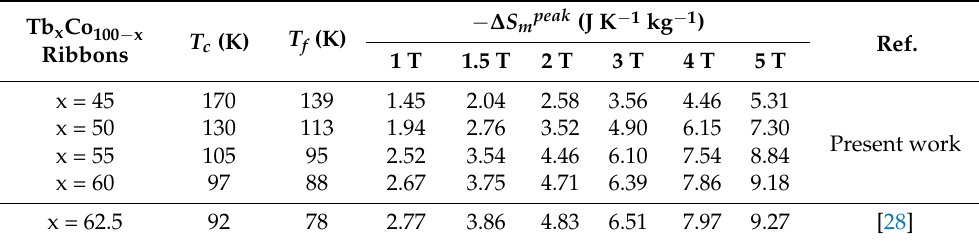
Figure 2. ( a ) FC M–T curves of the Tb x Co 100-x (x = 45, 50, 55, 60, 62.5) amorphous ribbons; ( b ) the relationship between the T c and the RE element content in the Tb x Co 100-x , Dy x Co 100-x and Gd x Co 100-x amorphous alloys. Table 1. The Curie temperature ( T c ), spin freezing temperature ( T f ) and −Δ S mpeak under various magnetic fields of the Tb x Co 100-x amorphous ribbons.